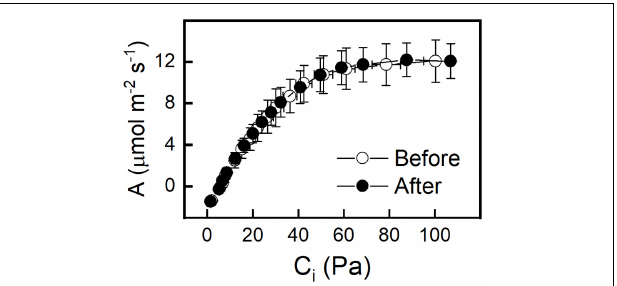
FIGURE 3 | A – C i curves of Col-0 taken before and after 4 h incubation at a PFD of 500 µ mol m − 2 s − 1 and C a of 400 ppm. A – C i curves were done at a PFD of 500 µ mol m − 2 s − 1 . n =